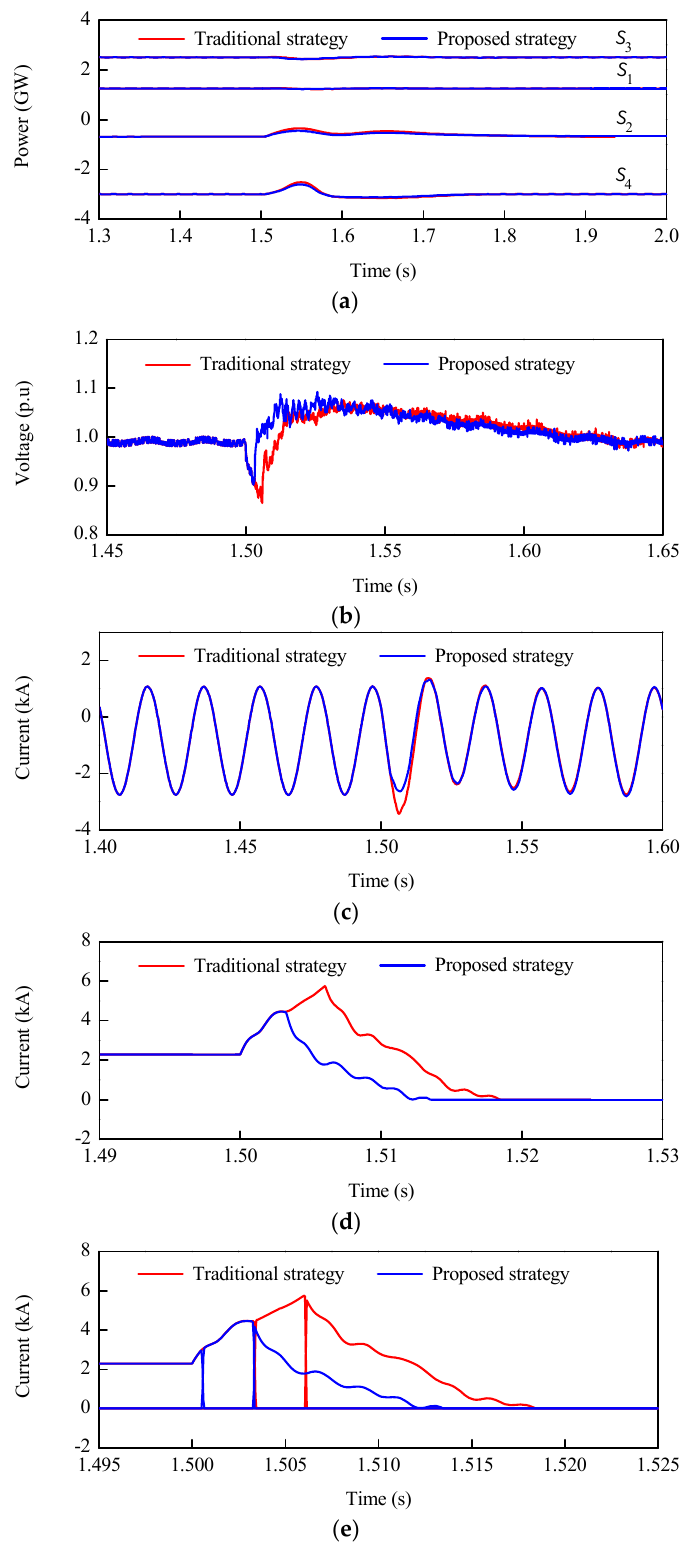
Figure 10. Simulation results: ( a ) active power of all stations; ( b ) DC voltage of station S 3 ; ( c ) the upper arm current in phase A of station S 3 ; ( d ) DC current of OHL 34 from S 3 –S 4 ; ( e ) currents of all branches in HDCB 34p .